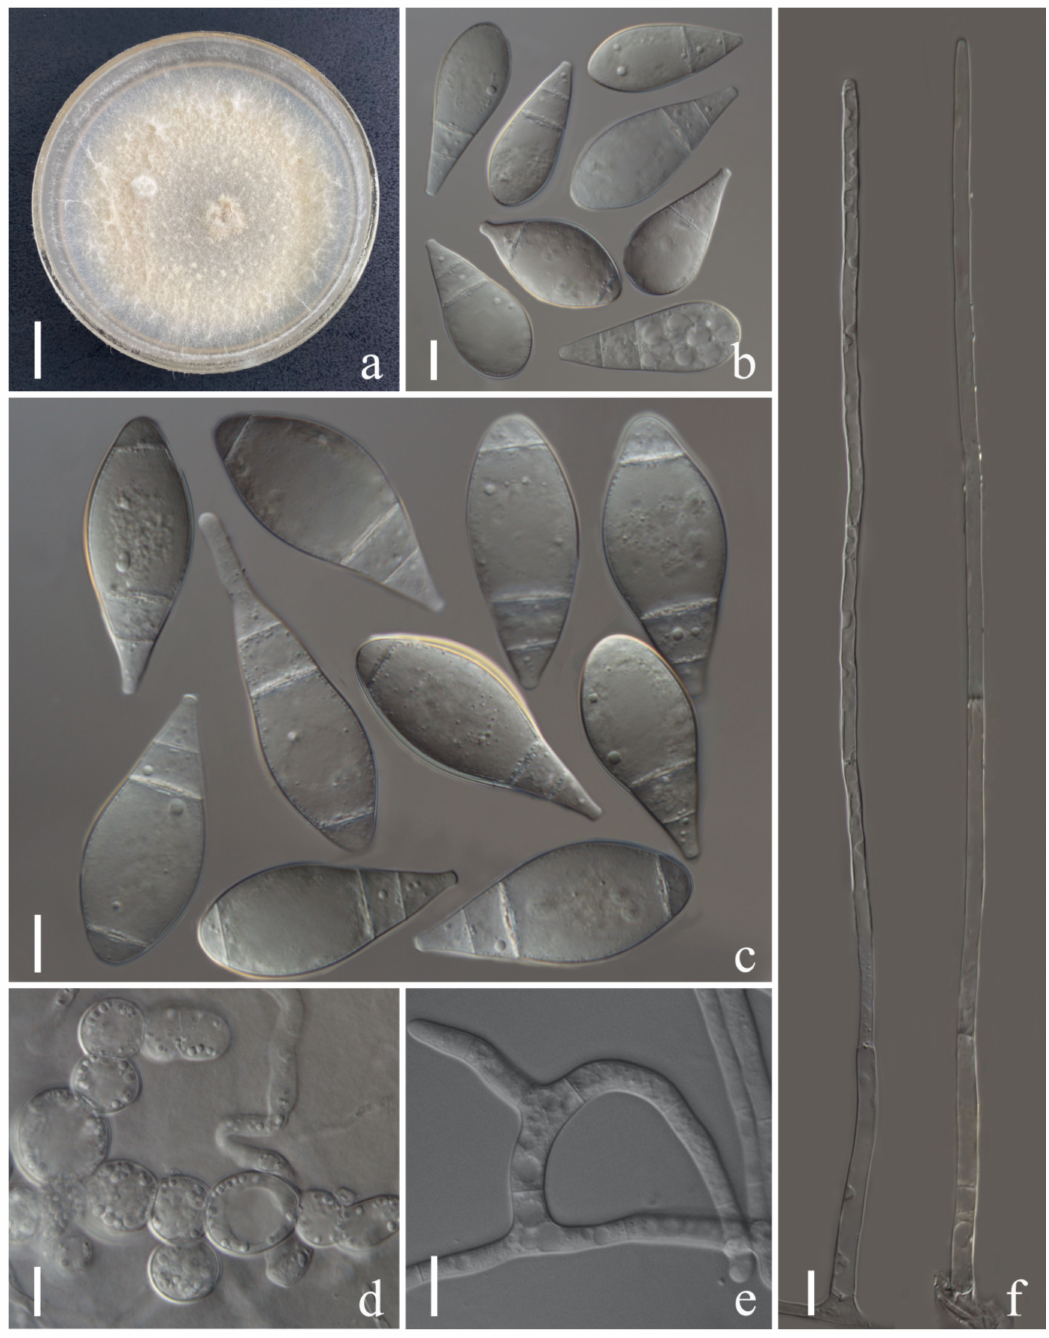
Figure 4. Arthrobotrys lanpingensis (CGMCC3.20998). ( a ) Colony. ( b , c ) Conidia. ( d ) Chlamydospores. ( e ) Trapping device: adhesive networks. ( f ) Conidiophores. Scale bars: ( a ) = 1 cm, ( b – f ) = 10 µ m. Notes: Phylogenetically, Arthrobotrys lanpingensis formed a sister lineage to A. psy- chrophila , A. salinum and A. gampsospora with 91% MLBS, 90% MPBS, and 0.90 BYPP support. A. lanpingensis was 9.3% (56/602 bp), 6.4% (32/503 bp), and 8.7% (50/576 bp) different from A. gampsospora , A. psychrophile , and A. salinum in ITS sequences, respectively. Mor- phologically, A. lanpingensis is most similar to A. guizhouensis in their subfusiform conidia. However, A. guizhouensis produces two types of conidia, while A. lanpingensis produces only one type of conidia. In addition, most conidia of A. lanpingensis are 3-septate, whereas the conidia of A. guizhouense are 2-septate, and the conidia of A. lanpingensis are